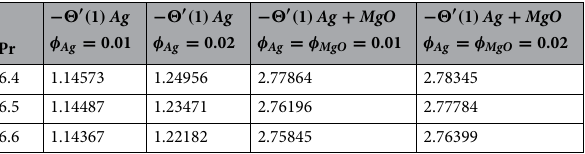
Table 3. Numerical outputs of Nusselt number − � ′ ( 1 ) at the surface of cone.